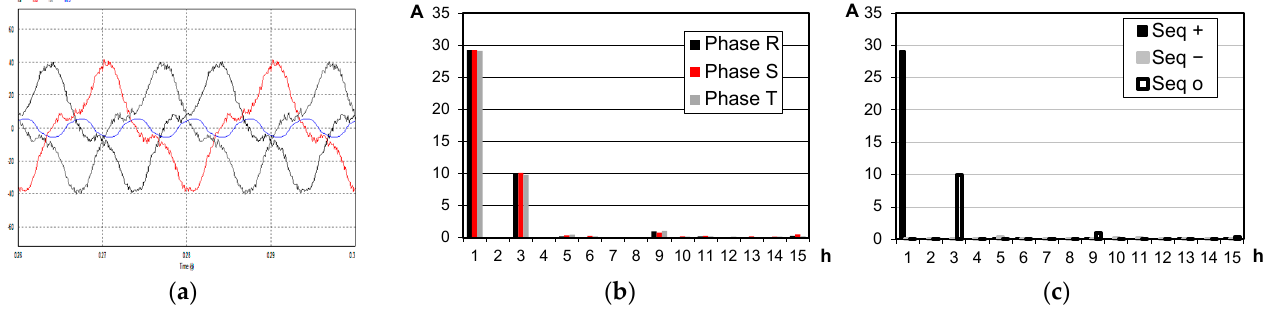
Figure 11. Case B - ( a ) supply currents (phases R , S , and T and neutral); ( b ) harmonic spectrum of phase components; ( c ) harmonic spectrum of the symmetric components.